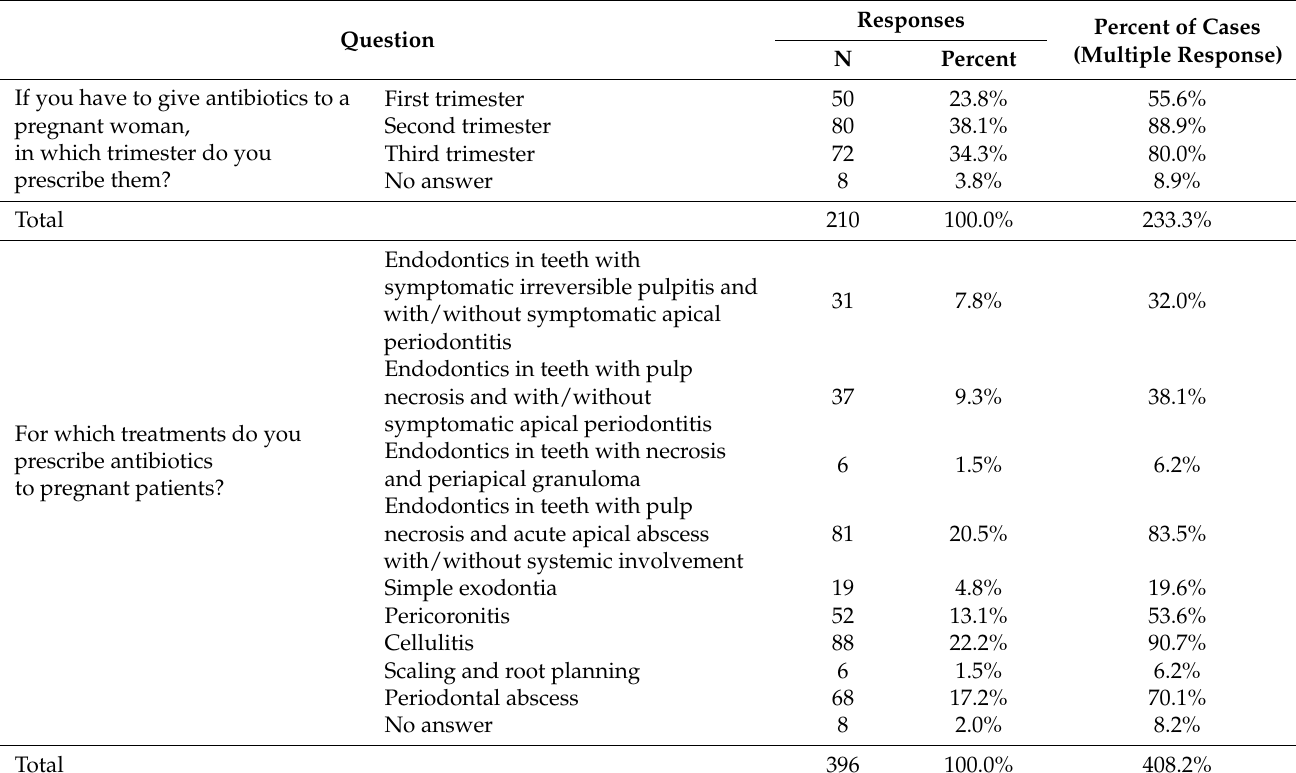
Table 5. Percentage distribution of responses and multiple response analysis for the knowledge questions.